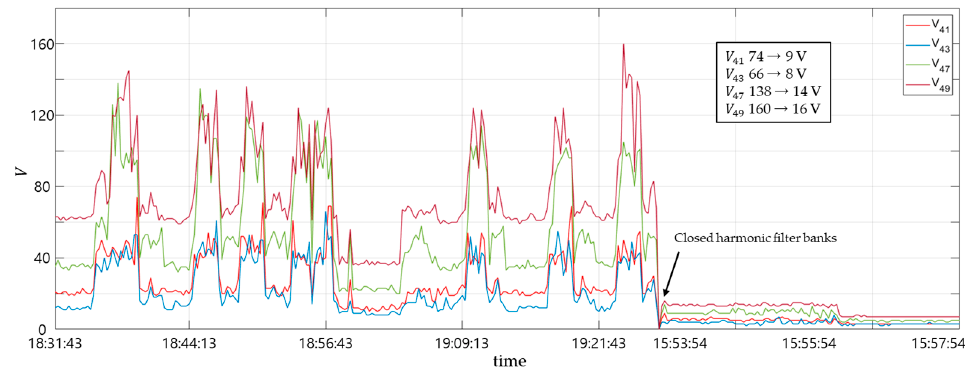
Figure 14. Measured 𝑉 (cid:3035)((cid:2872)(cid:2869),(cid:2872)(cid:2871),(cid:2872)(cid:2875),(cid:2872)(cid:2877)) on 22 kV system. Figure 14. Measured V h ( 41, 43, 47, 49 ) on 22 kV